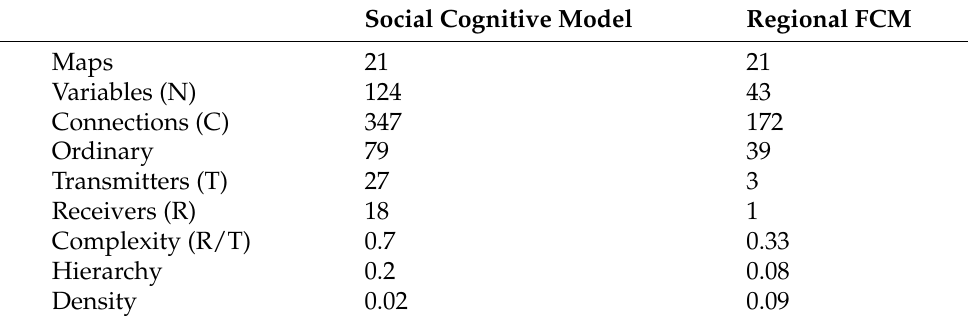
Table 2. The social cognitive model and regional FCM were generated by aggregating the individual stakeholder FCMs. The regional FCM used only variables that were mentioned more than once by stakeholders and is therefore a conservative representation of the stakeholders’ perception of stormwater management in the Research Triangle, North Carolina, at the time of the